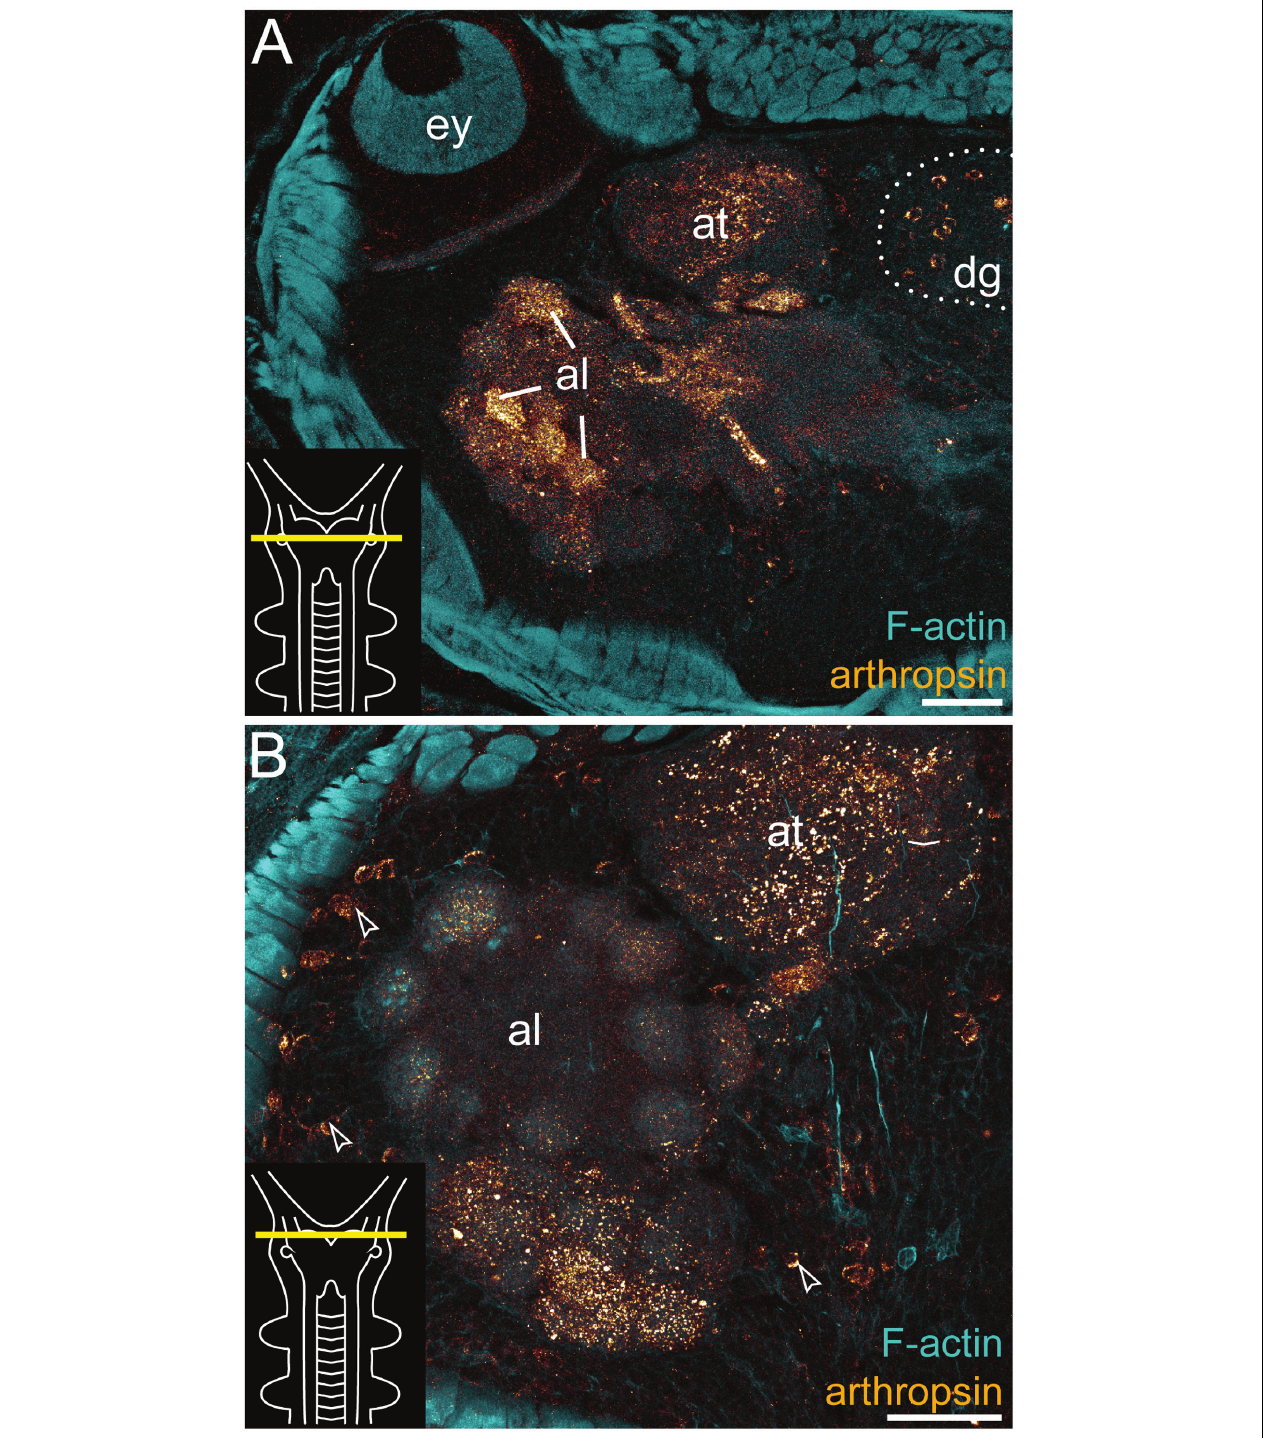
FIGURE 5 | Immunolocalization of arthropsin in the nervous system of Euperipatoides rowelli . Vibratome cross sections of heads. Confocal micrographs. Double-labeling with anti-arthropsin antibody (glow-mode) and phalloidin-rhodamine (cyan). Dorsal is up in all images. Insets in the lower left corners illustrate sectional planes (yellow bars). (A) Detail of a cross section at the level of the eye. Note numerous immunoreactive fiber bundles in the antennal glomeruli and the antennal tract and the complete lack of immunoreactivity within the eye. Note also a dorsal group of immunoreactive somata (dotted line). (B) Detail of the brain region containing the antennal lobe. Note immunoreactive fibers in the antennal lobe and adjacent somata of immunoreactive neurons (arrowheads). Abbreviations: al, antennal lobe; at, antennal tract; dg, dorsal group of somata (encircled by a dotted line); ey, eye. Scale bars: 75 µ m (A) , 50 µ m (B) .